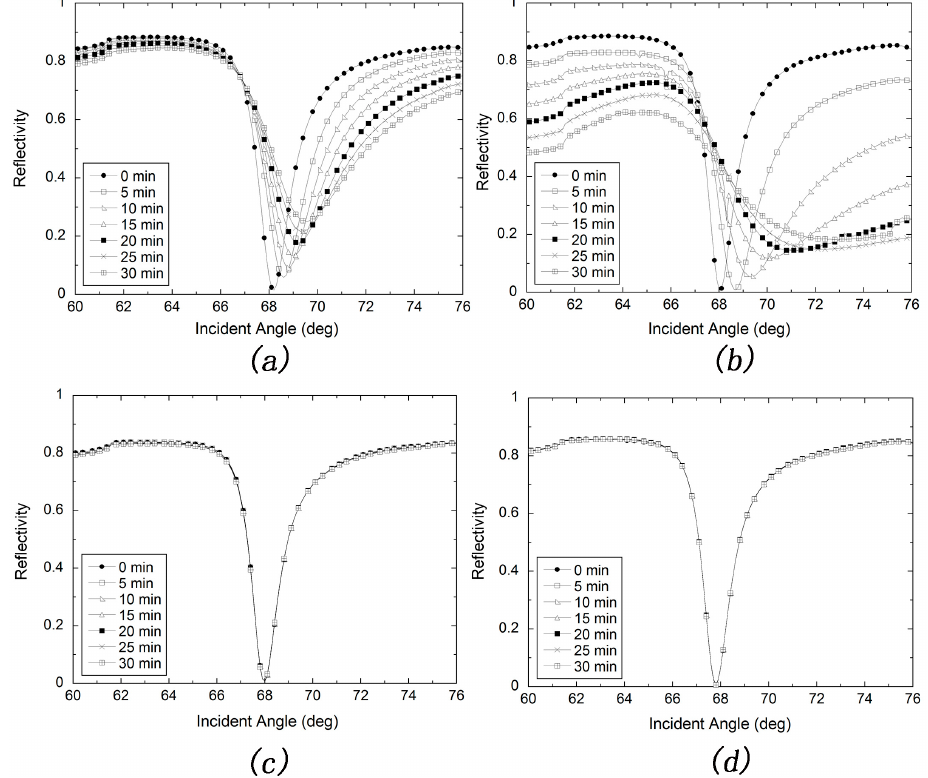
Figure 3. Continuous stability tests of silver-based SPR with a speed of 100 uL/min. ( a ) in water environment without an 11-mercapto-1-undecanol (MUD) self-assembled monolayer (SAM) protection layer; ( b ) in 0.01 M PBS buffer environment without a MUD SAM protection layer; ( c ) in a water environment with a MUD SAM protection layer; ( d ) in 0.01 M PBS buffer environment with a MUD SAM protection layer.